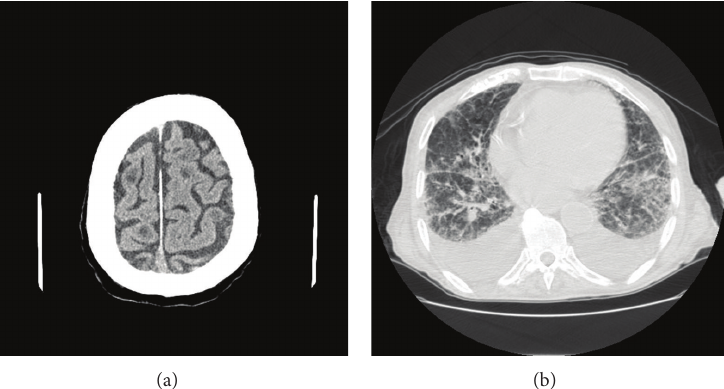
Figure3:(a)Computerizedtomography(CT)scanofthepatient’sbrainshowingmultipleenhancingfocallesions.(b)ChestCTscanshowing multiple nodular lesions and bilateral pleural